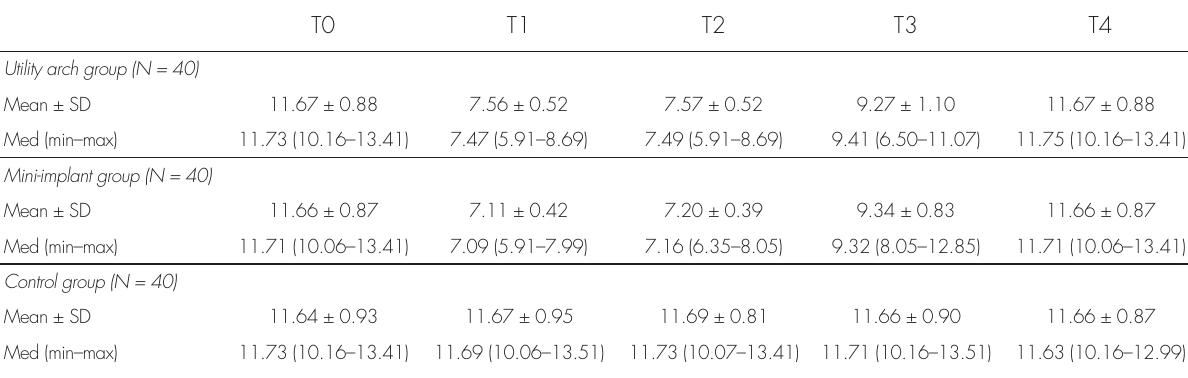
Table I. Maxillary incisor PBF values at T0, T1, T2, T3 and T4 for each